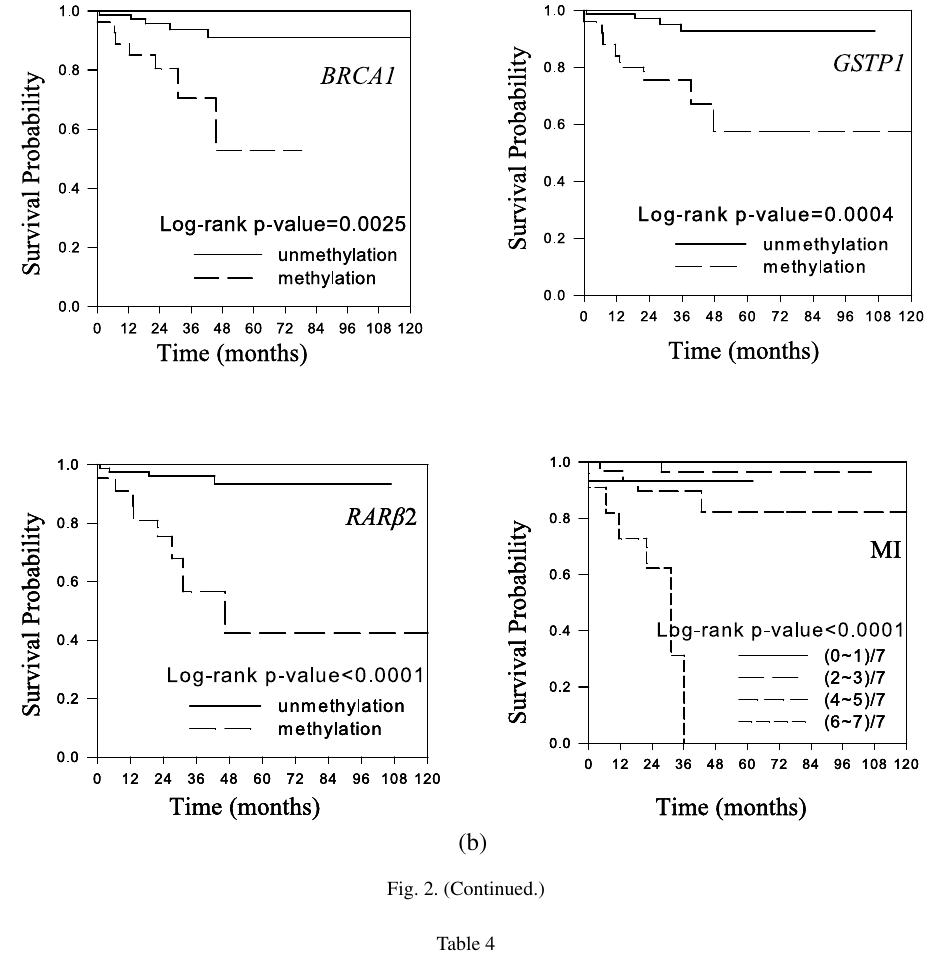
Multiple Cox regression analysis with backward selection for disease free survival and overall